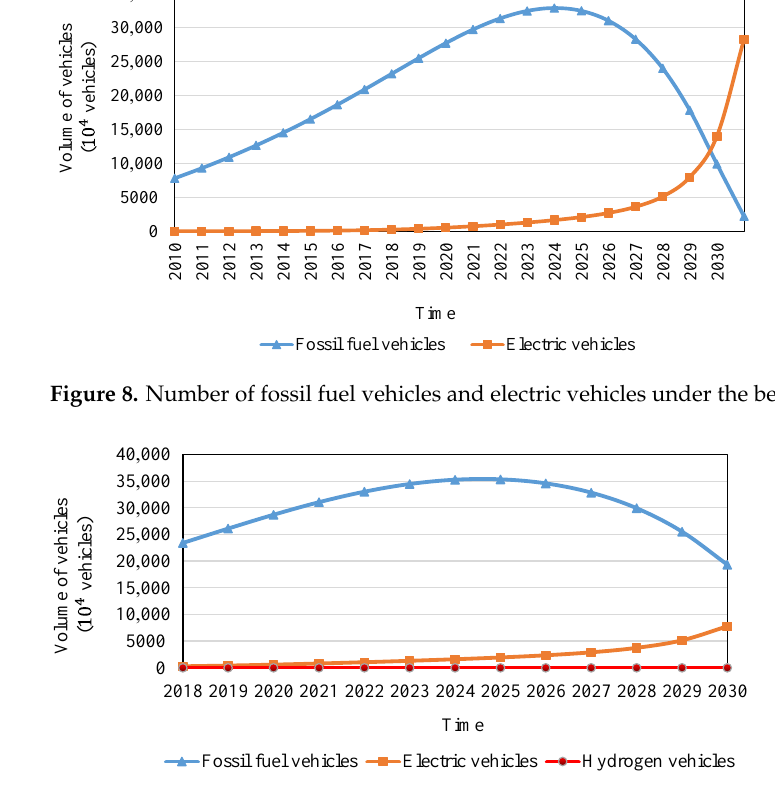
Figure 9. Number of vehicles under the competition scenario.